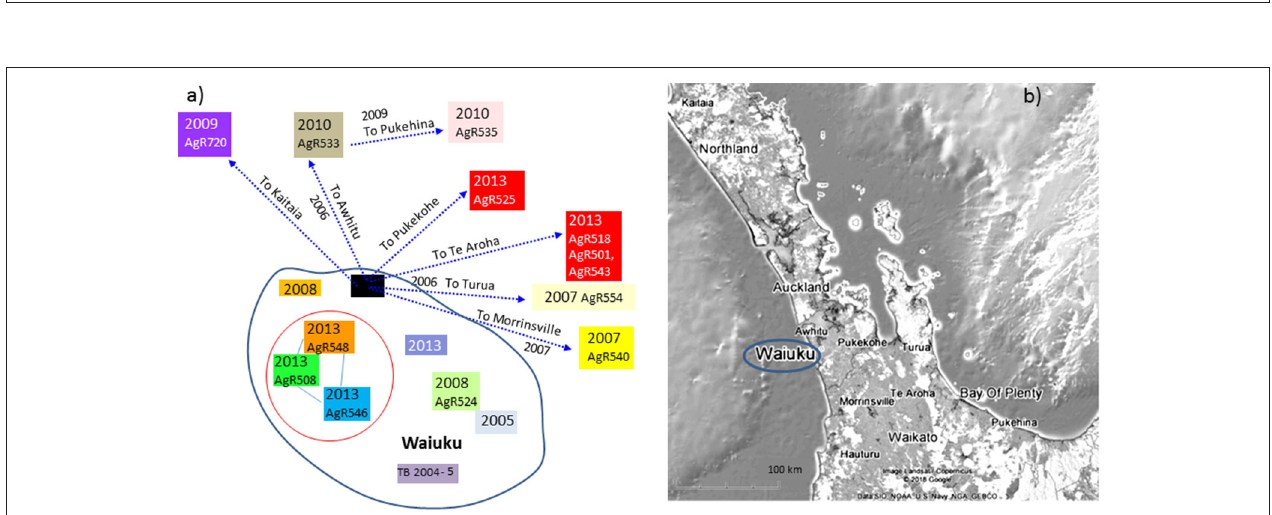
FIGURE 7 | Waiuku outbreak Transmission path. (a) The direction of spread deciphered from epidemiological investigation, (b) a map illustrating the geographical sources of the characterized isolates. Isolates that have been characterized by WGS are colored to match the genomic data shown in the SNP table in Figure 6B . Colored boxes without AgR numbers represent isolates that were not characterized by WGS. Isolates that are circled in red were not known to be linked by movement but were from farms within 4km of one another.